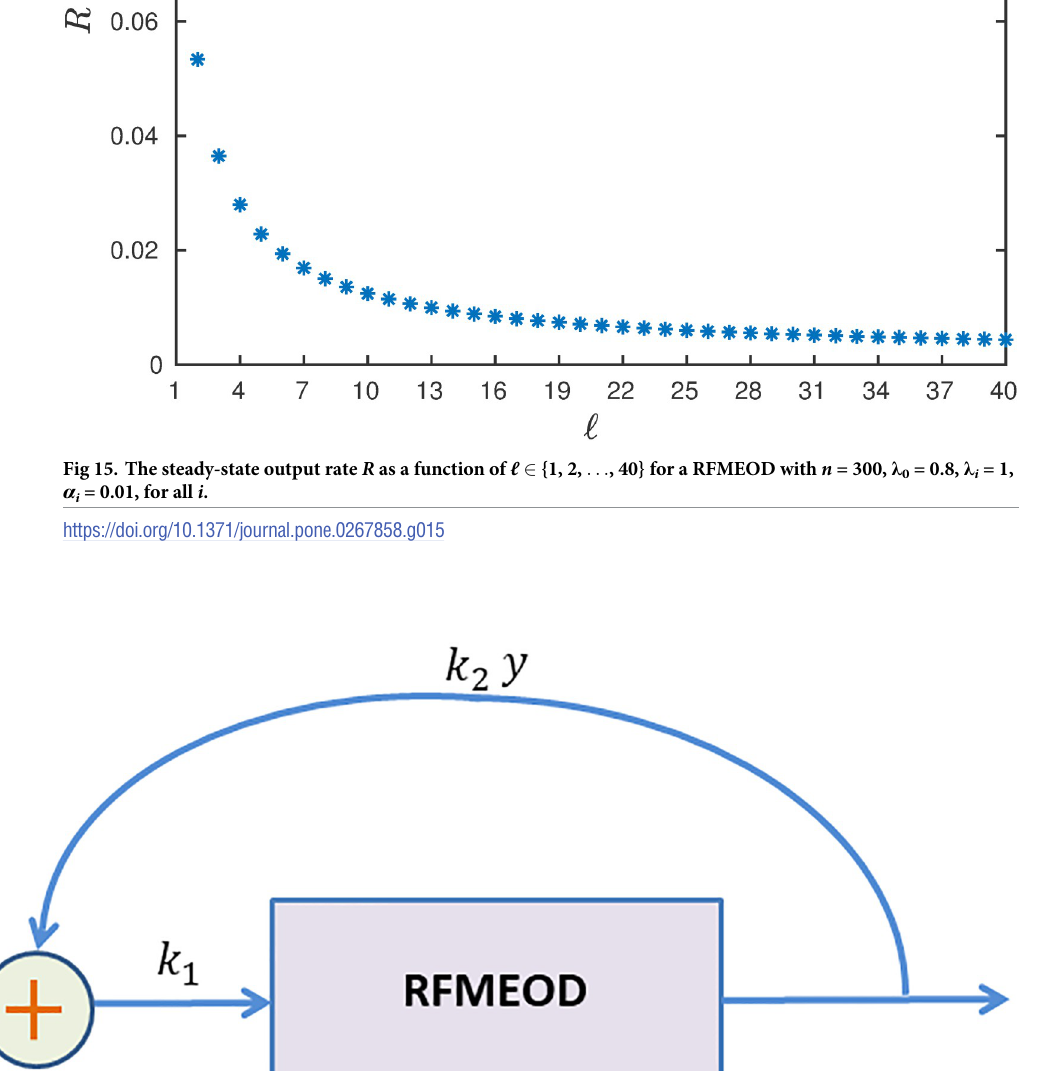
P n þ a denotes the output of ribosomes from the system. x x n n i i i ¼ 1